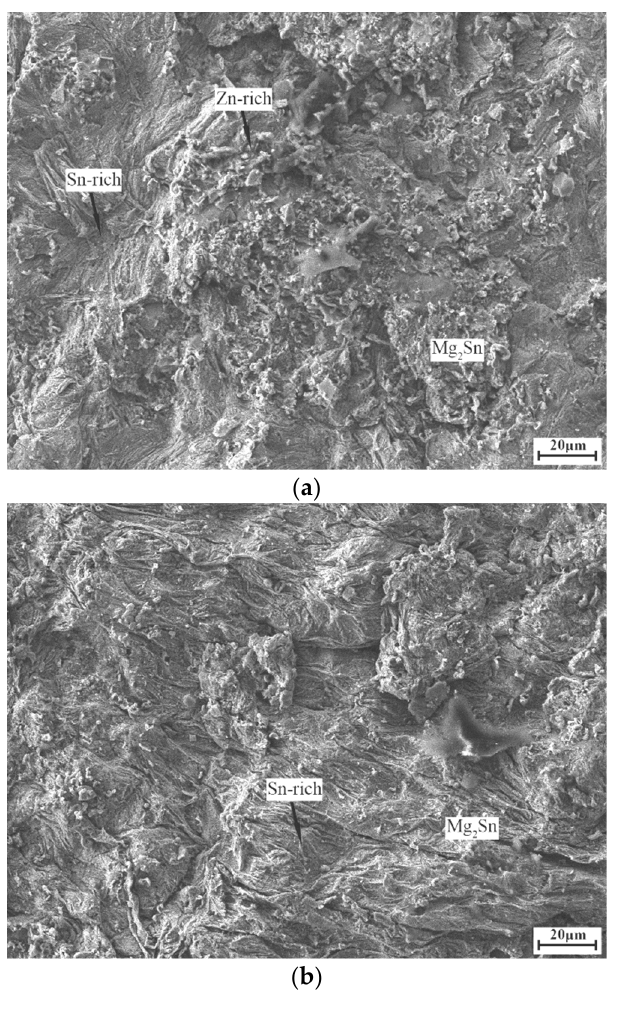
Figure 5. Fractography of the AZ31 magnesium alloy/6061 aluminum alloy joint bonded with the Sn-10Zn-0.1RE solder. ( a ) 6061 aluminum alloy side; ( b ) AZ31 magnesium alloy side.